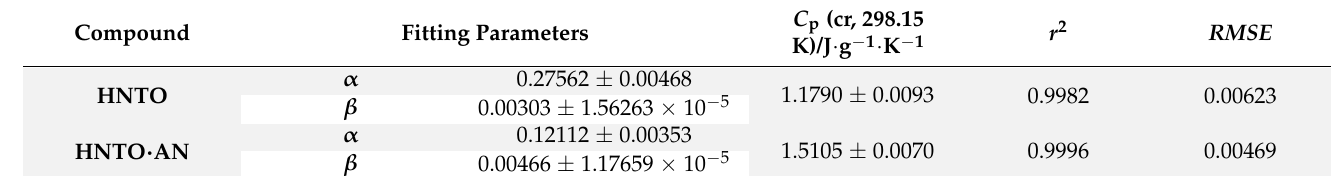
Table 1. Fitting parameters α and β , regression coefficients r 2 of the linear fitting curves, and the heat capacity for HNTO and HNTO · AN cocrystal at 298.15